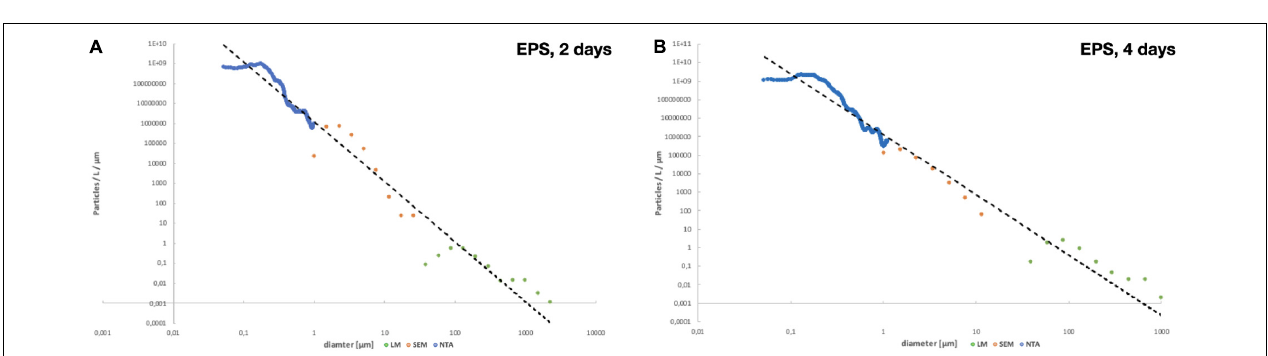
On the 1 µ m filter, we first identified the EPS particles with Raman spectroscopy and, together with the confocal image, a threshold in which only registered EPS particles were applied in the SEM to measure the size distribution of the particles on these filters. The nano-sized particles were measured with NTA, and the concentration was compared with blank samples as well as with pure Milli-Q